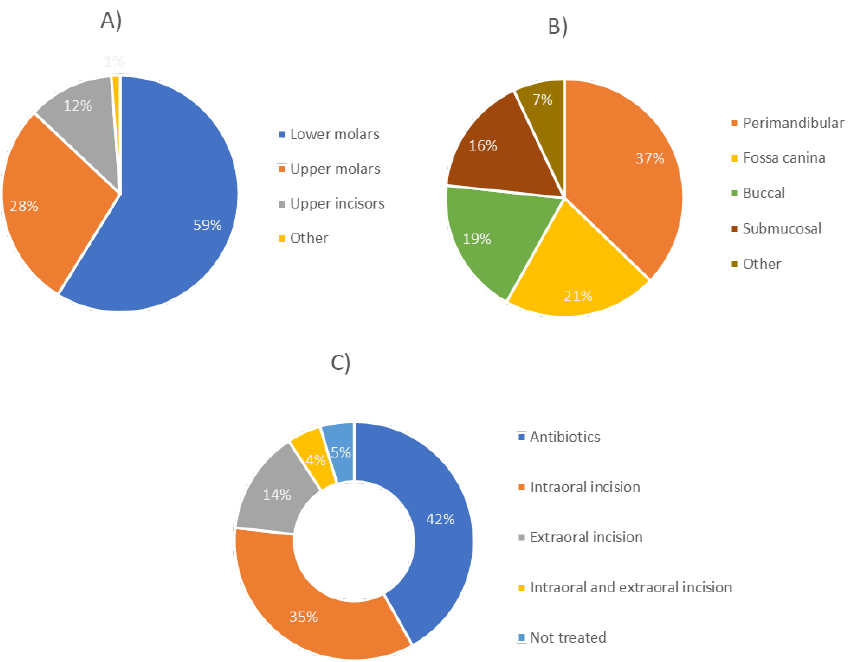
Figure 5. Distribution regarding causative tooth ( A ), abscess localization ( B ), and treatment modality ( C ) in pediatric patients with odontogenic abscess.